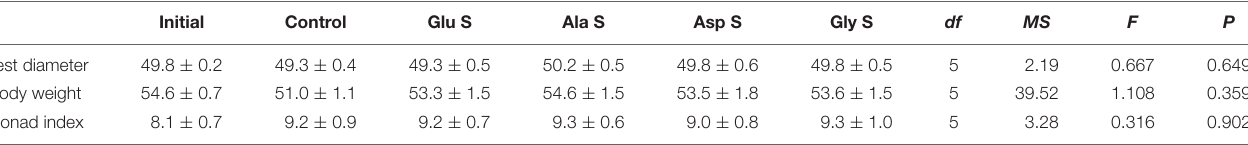
TABLE 2 | Test diameter (mm), body wet weight (g) and gonad indices of Mesocentrotus nudus of the initial group and in each treatment group at the end of the experiment (mean ± SE) ( n = 16). Initial